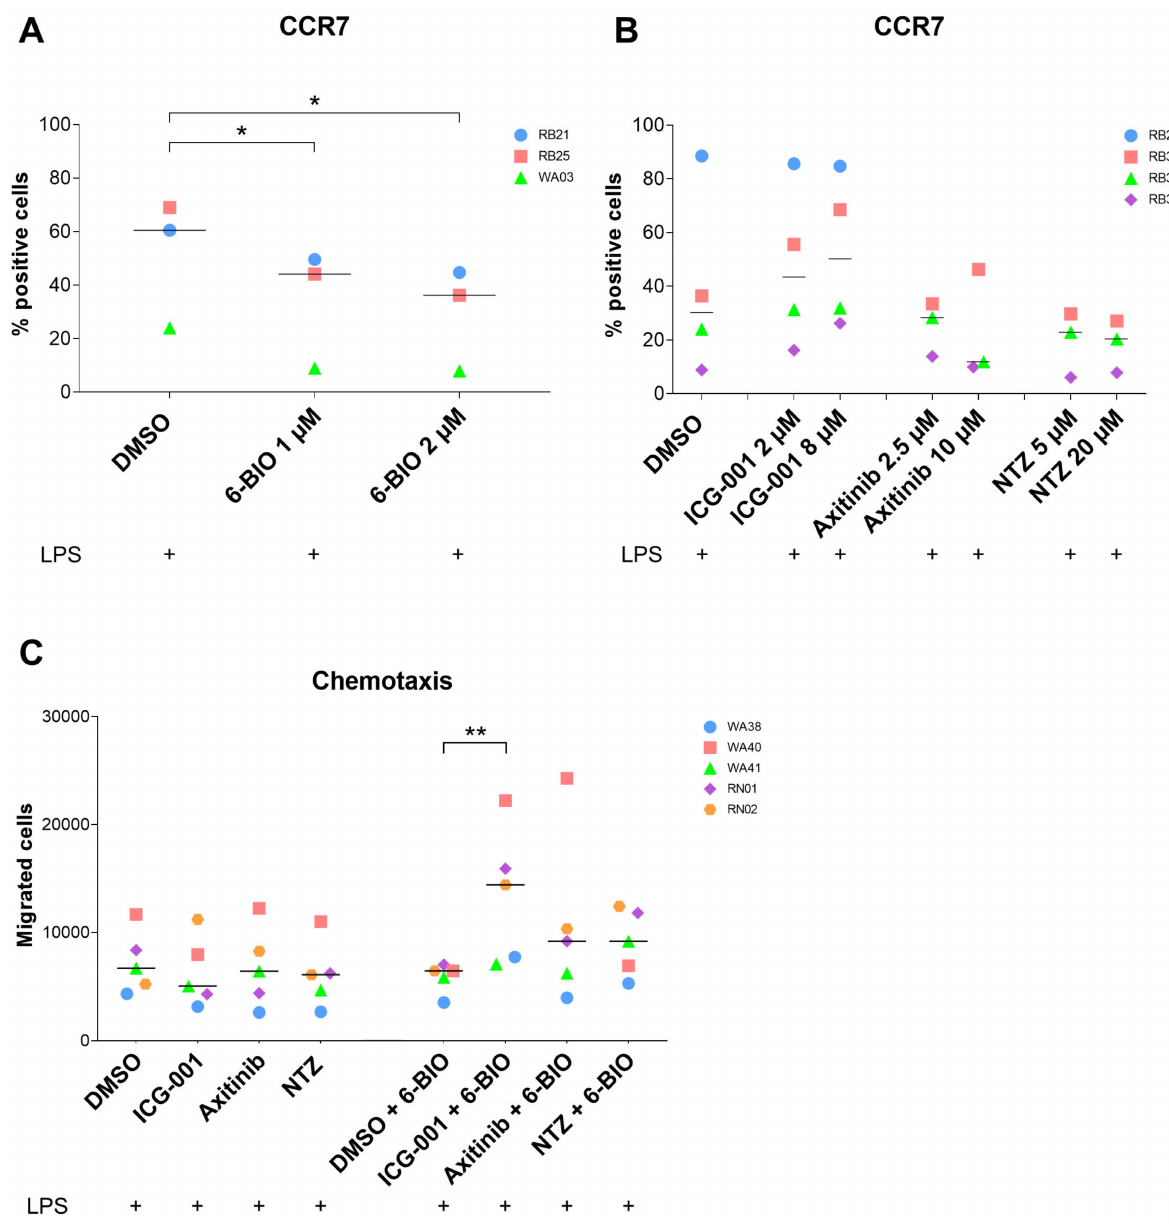
Figure 3. moDCs obtained from healthy donors were treated with 6-BIO or β -catenin inhibitors for 24 h. DMSO (vehicle) served as mature moDCs control and cells were treated with LPS for the last 23 h. ( A , B ) CCR7 cell surface marker was measured with flow cytometry and shown as change of percentage of positive cells following indicated compound treatments. ( C ) moDCs were treated with indicated β -catenin inhibitors (4 µ M ICG-001,10 µ M axitinib, 10 µ M nitazoxanide (NTZ)) with or without 0.5 µ M 6-BIO or DMSO (vehicle). A total of 50,000 cells were added to the upper chamber of an 8 µ m trans-well 96-well plate and incubated for 4 h at 37 ◦ C to migrate towards CCL19 (100 ng/mL) in the lower chamber. The migrated cells were counted using a CASY™ cell counter. Each symbol represents a different donor, and lines represent the median. Donors were anonymized and each buffy coat labeled by initials of experimenter (RB/RN or WA) and consecutive buffy coat number. * p ≤ 0.05, ** p ≤ 0.01 by using two-way ANOVA followed by Dunnett’s multiple comparisons test with 95% confidence interval. For comparison tests, the cells treated either with β -catenin inhibitors only or with combination between β -catenin inhibitors and 6-BIO were compared with DMSO or DMSO + 6-BIO controls,